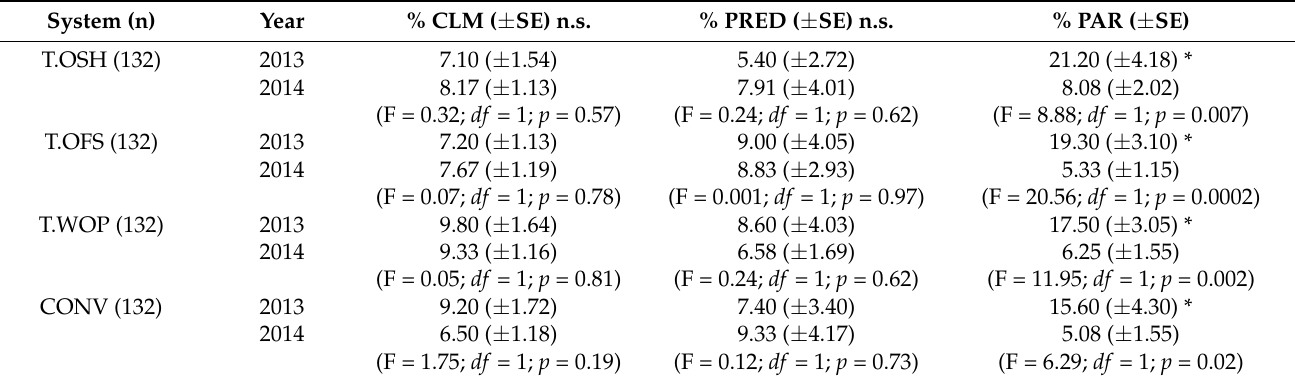
Table 4. The mean percentage of coffee leaf miner infestation (%CLM), predation (%PRED), and parasitism (%PAR) during 2013 and 2014 within conventional and three agroecological transitions systems of coffee plants (Coffea arabica